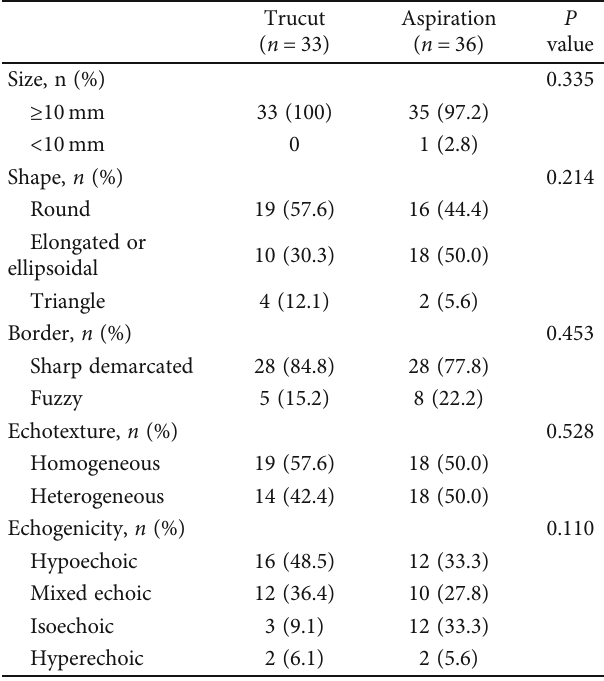
Table 3: Endosonographic feature of lymph